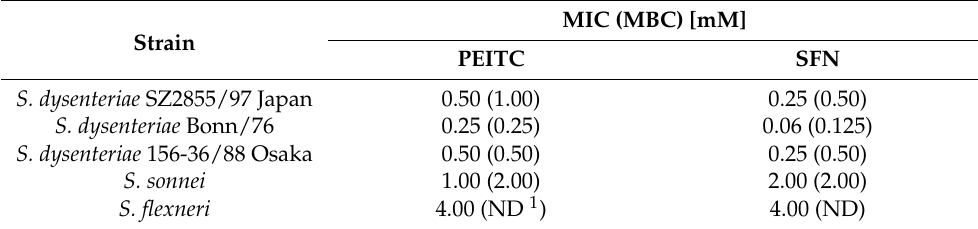
Table 1. Susceptibility of Shigella species to PEITC and